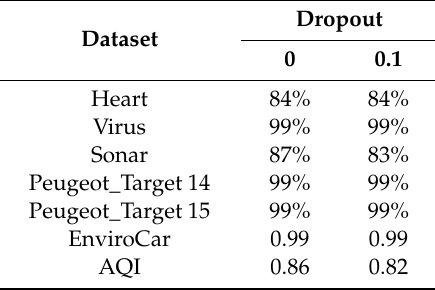
Table 33. Dropout e ff ect on